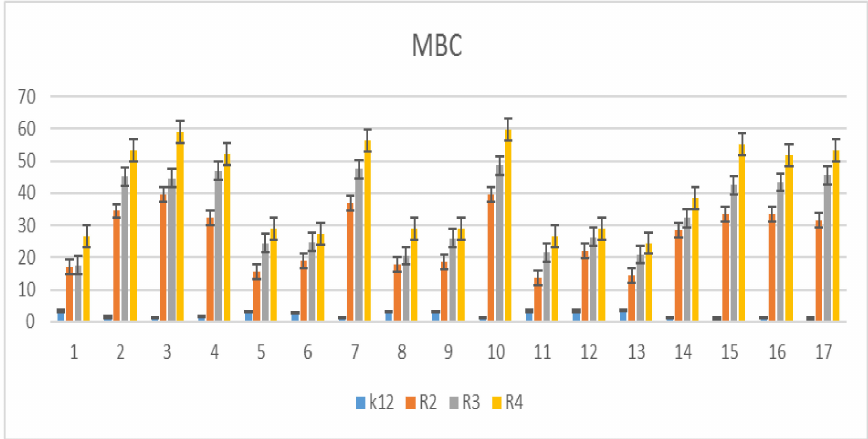
Figure 4. MBC of the coumarin derivatives in model bacterial strains. On the x -axis, 17 compounds were used sequentially. The y -axis shows the MBC value in µ g/mL − 1 (see Supplementary Materials).